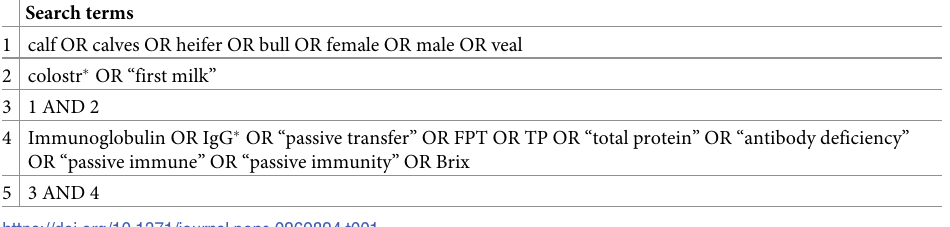
Table 1. Search strings used to collect studies related to colostrum characteristics and management and their rela- tion to transfer of passive immunity in dairy calves. Search